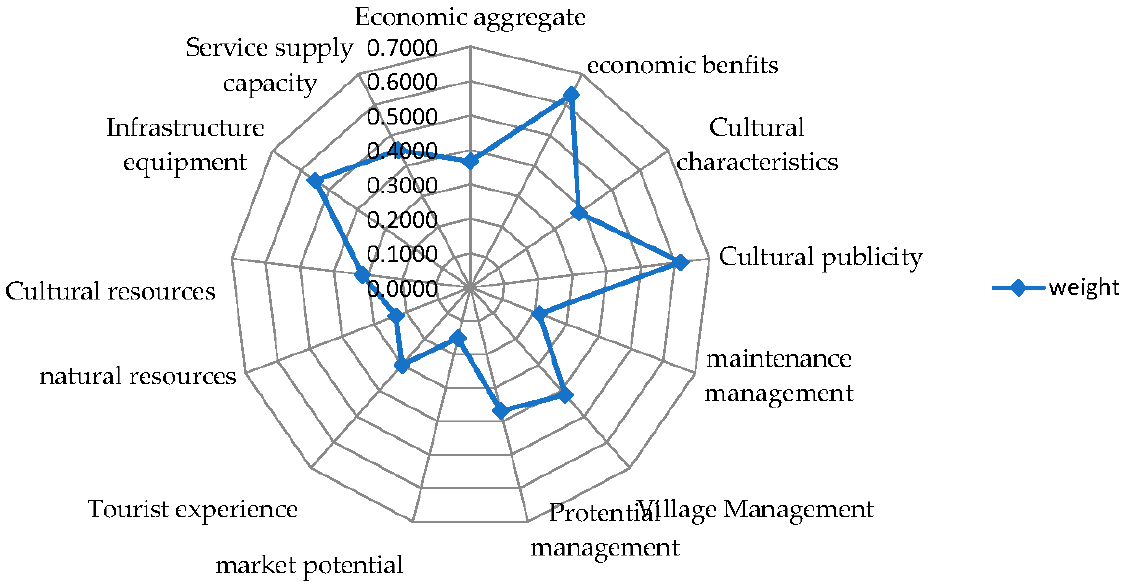
Figure 2. Sub-criterion Layer Weight Radar Chart.